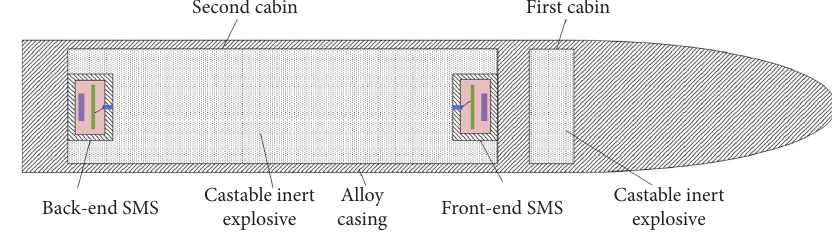
Figure 2: Structure of the penetrator.